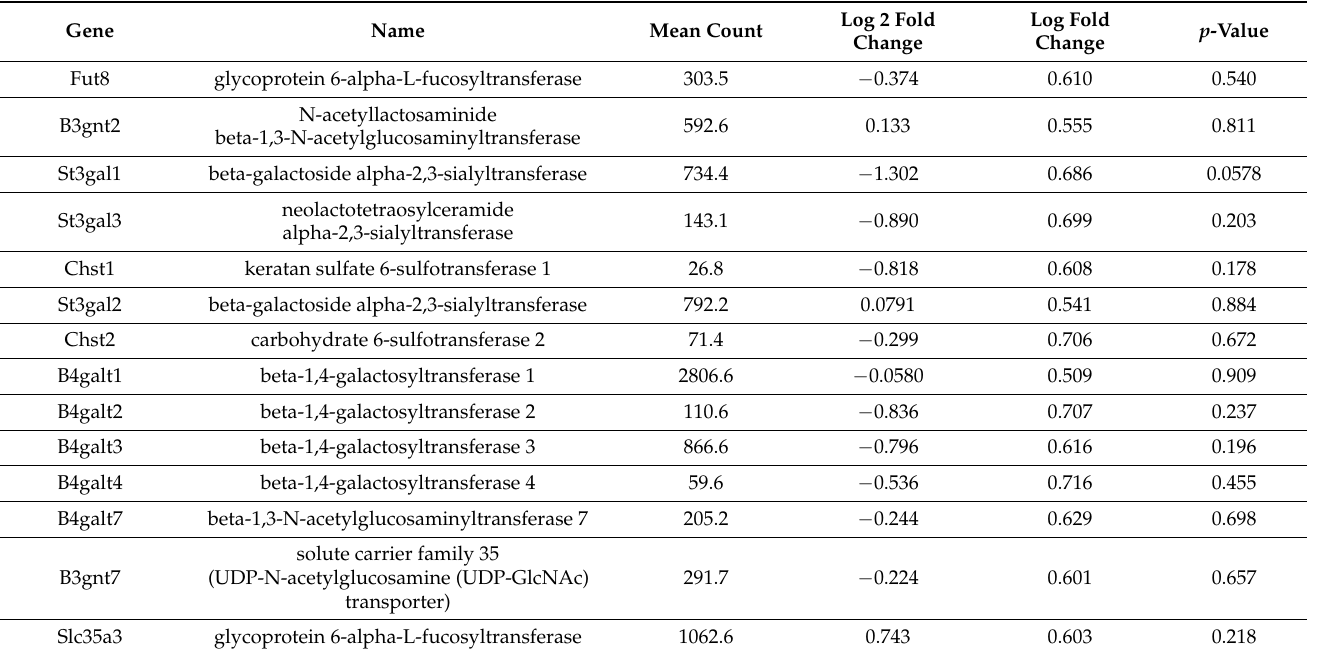
Table 3. Identification of KS biosynthetic enzymes by RNAseq